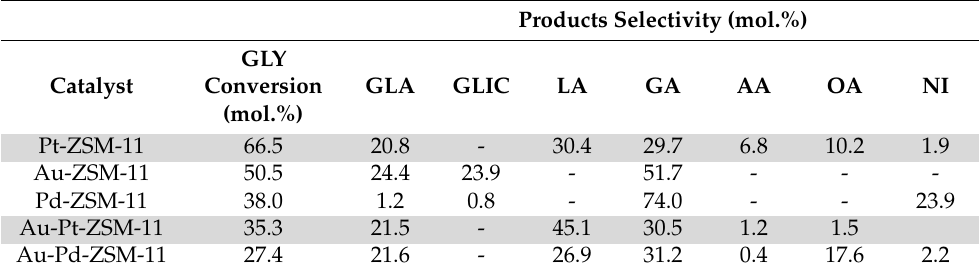
Table 3. Performance of different metal-supported catalysts in GLY oxidation after 4 h of reaction. Products Selectivity